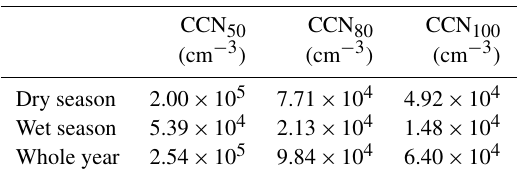
Figure 4. Median (a) absolute and (b) relative CCN productions from NPF, i.e. corrected for the transport of CCN-sized particles to the site, for the different activation diameters and seasons (wet and dry). Table 2. Estimation of the median seasonal and annual CCN in- creases from NPF, i.e. corrected for the contribution of particles transported to the